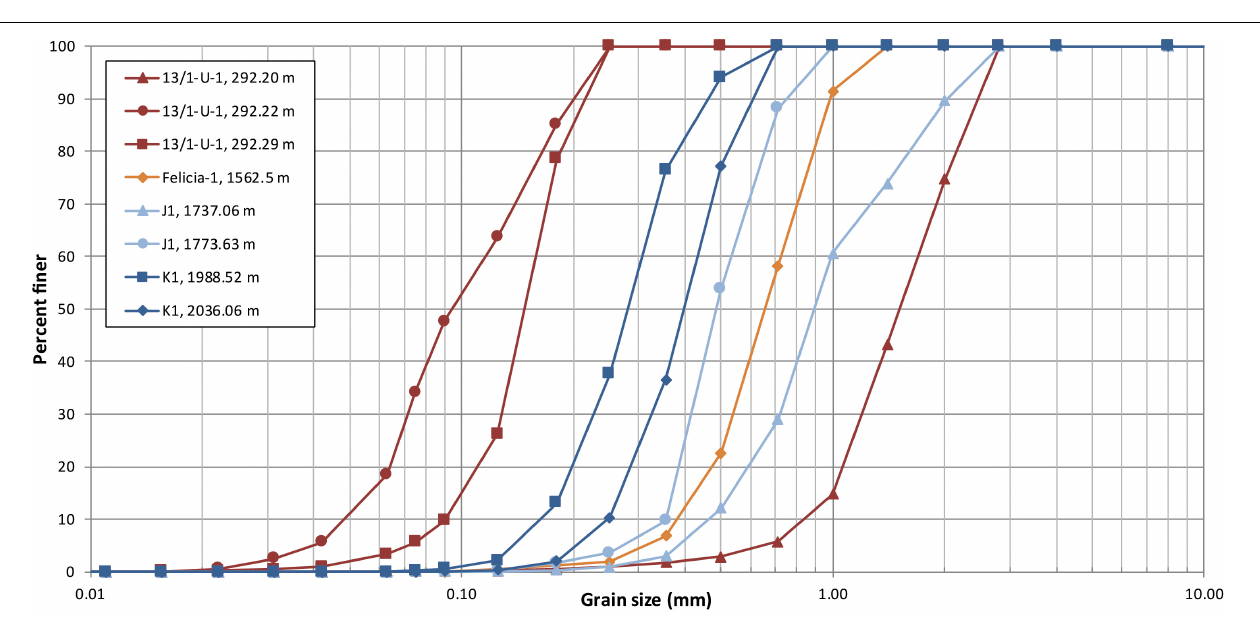
FIGURE 7 | Schematic north-south section from the Sorgenfrei-Tornquist Zone offshore Norway to the Norwegian-Danish Basin offshore Denmark. The sequence stratigraphic framework made by Nielsen (2003) is applied. The potential injection site is projected (see Figure 1 ).